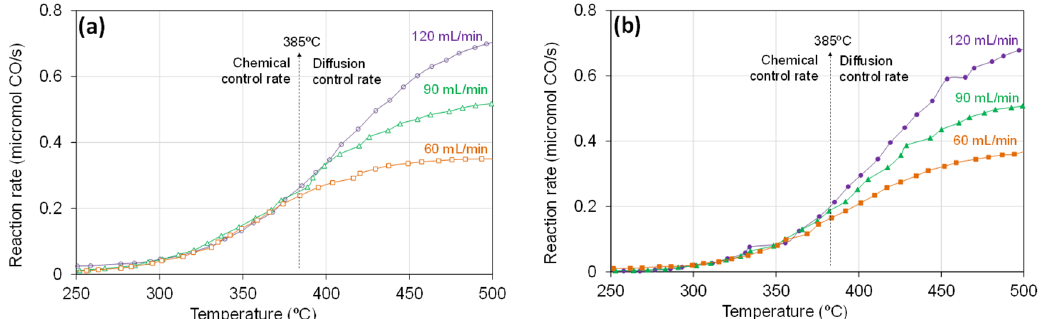
Figure 2. CO oxidation rate as a function of temperature for catalytic tests performed with ( a ) Ce-Pr-3DOM and ( b ) Ce-Pr-ref with different total gas flows. (1% CO + 17% O 2 in N 2 ; 50 mg of catalyst).